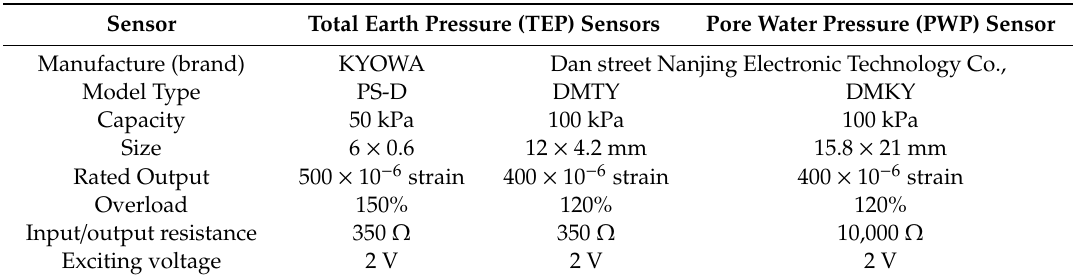
Figure 1. A small-scale model of a mine stope made of transparent plexiglass, including the measurement tools. Table 1. Geometric characteristics of the three types of stress sensors used on the reduced